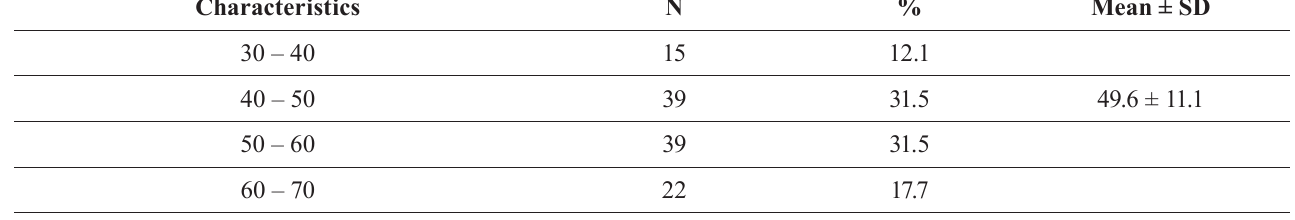
TABLE IV - Sociodemographic characteristics of the participants in the evaluation of quality of life in the city of Cascavel – PR